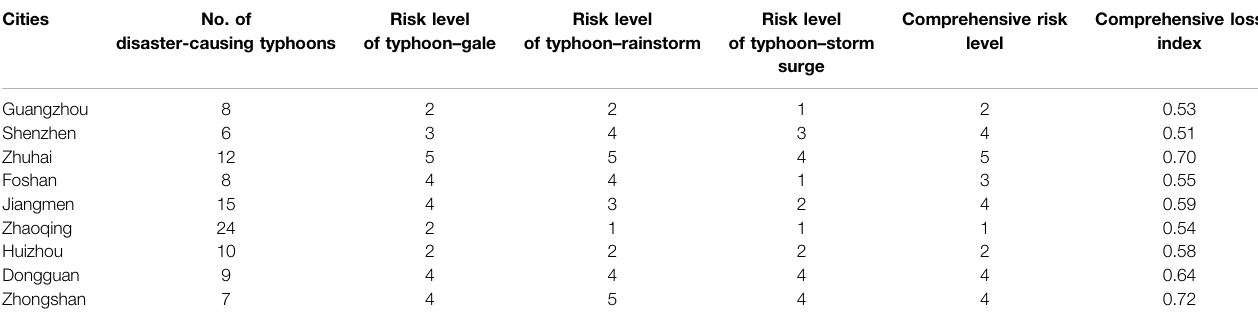
TABLE 9 | The number of disaster-causing typhoons, disaster risk level, and comprehensive loss index in each city of the GBA from 2009 to 2020. Cities No. of disaster-causing typhoons